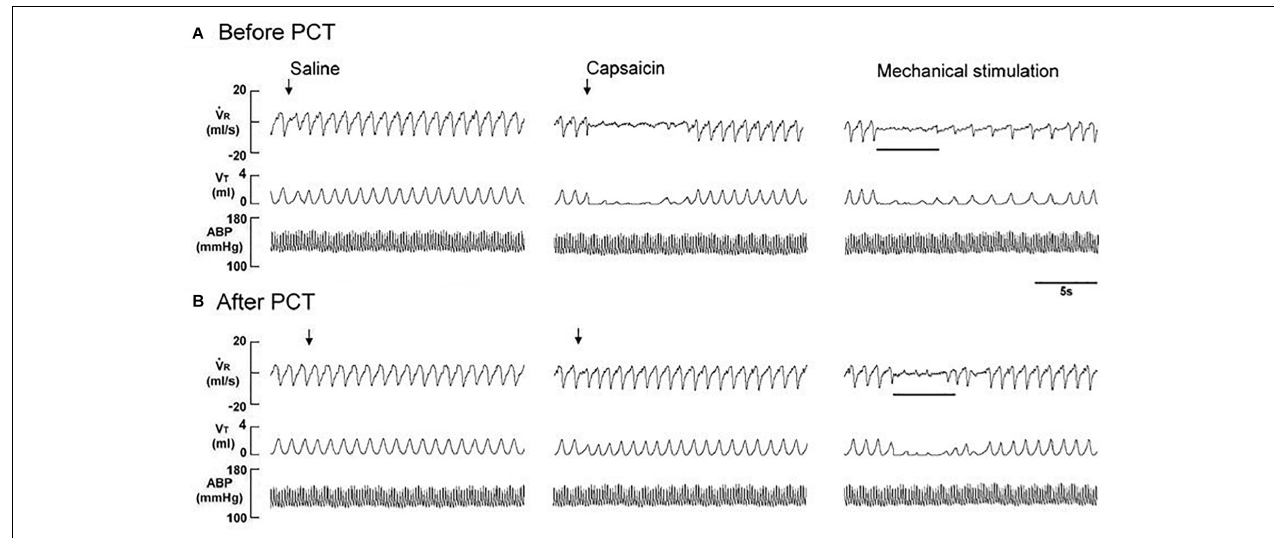
FIGURE 3 | Immediate responses to laryngeal provocations of saline and capsaicin, and to laryngeal mechanical stimulation before (A) and after perineural capsaicin treatment (PCT; B ) of superior laryngeal nerves in a rat exposed to intermittent hypoxia for 14 days. Saline or capsaicin (0.08 µ M) in 30 µ L volume was locally applied to the larynx (indicated by an arrow). Duration of laryngeal mechanical stimulation is indicated by the horizontal bars. The elapsed time between the two challenges was 20 min. ˙V R , respiratory flow; V T , tidal volume; ABP, arterial blood pressure.